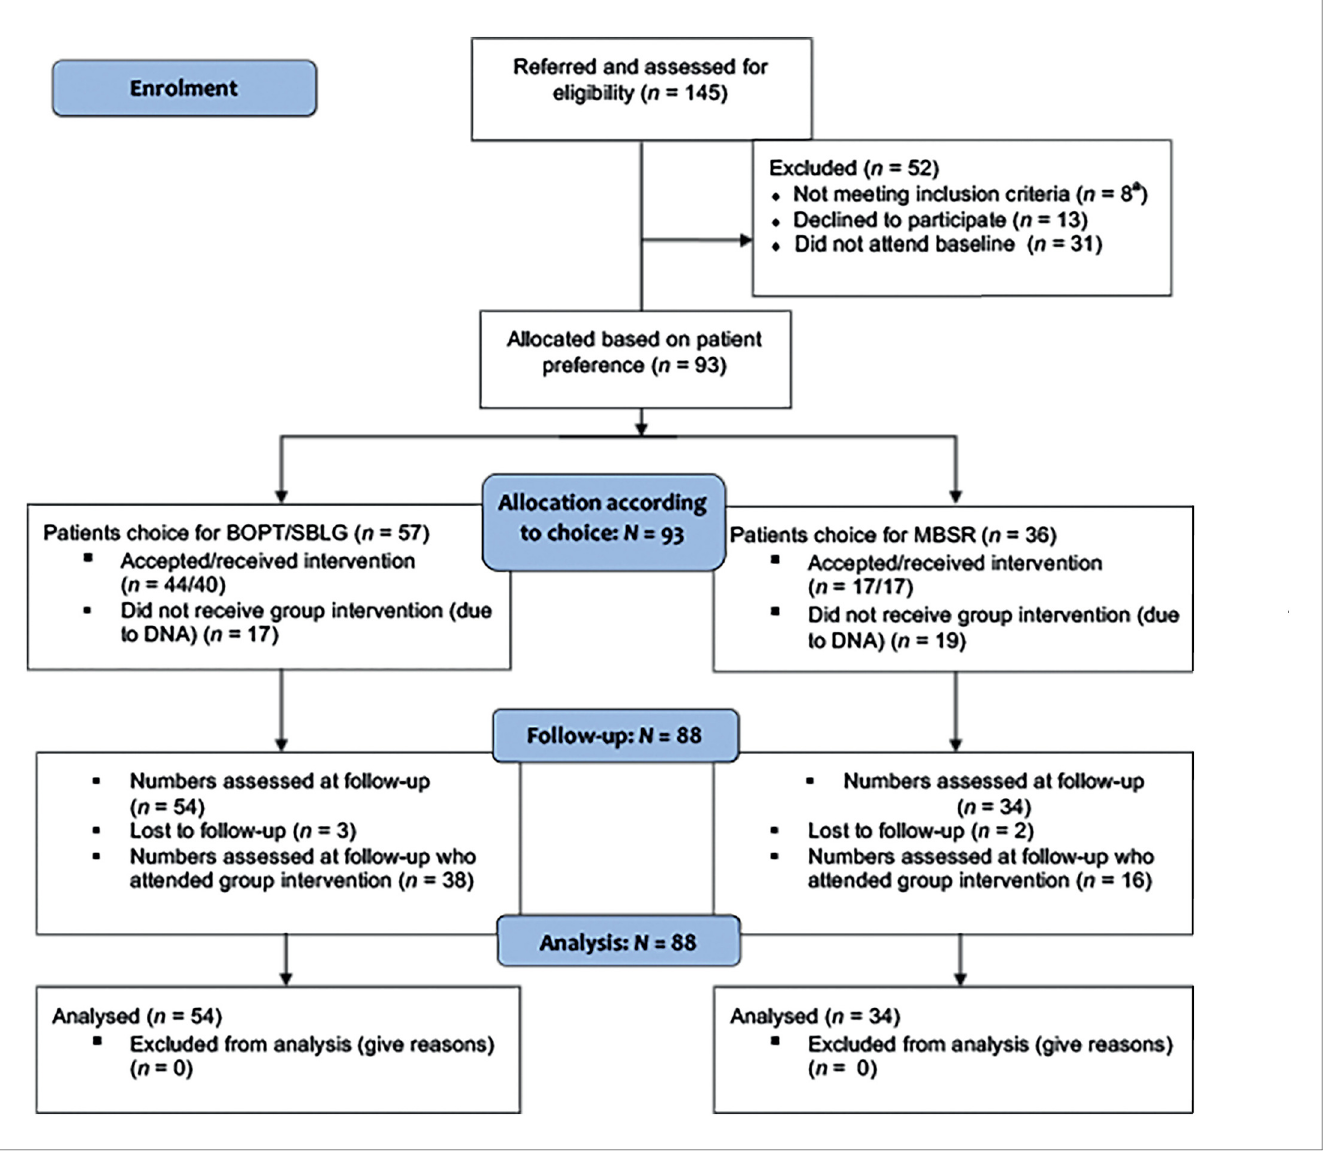
Figure 1 CONSORT flow diagram. a 1 patient aged <18 years with dementia, 1 patient out of area, 5 patients aged >75 years with high-level multimorbidity. BOPT = body oriented psychological therapy. DNA = did not attend. MBSR = mindfulness-based stress reduction. SBLG = Short Form for Strategies for Better Living